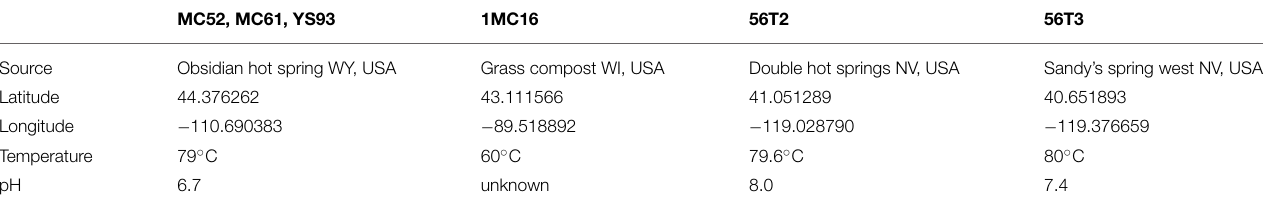
TABLE 1 | Geobacillus genomes sequenced in this work. MC52, MC61,